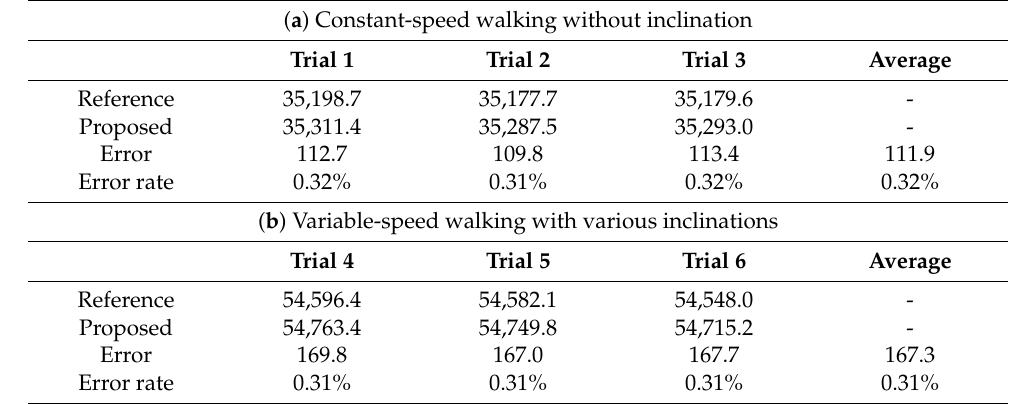
Table 2. TTD errors of the tests with pedestrian walking (unit: